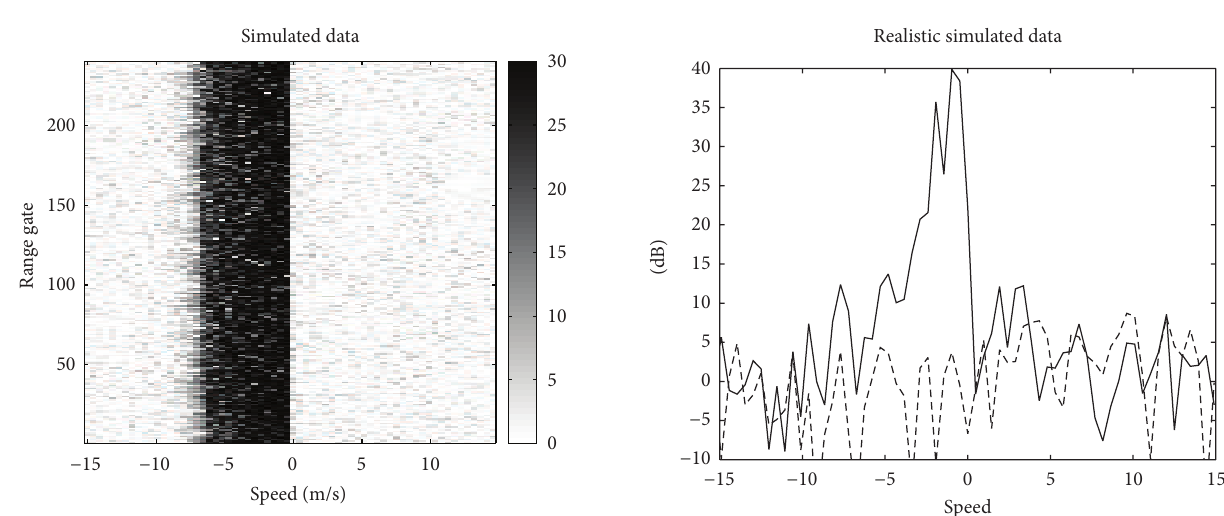
Figure 6: Comparison between sum channel (bold curve, negative speeds), deterministic (bold, positive speeds), and STAP (dash) on realistic data.